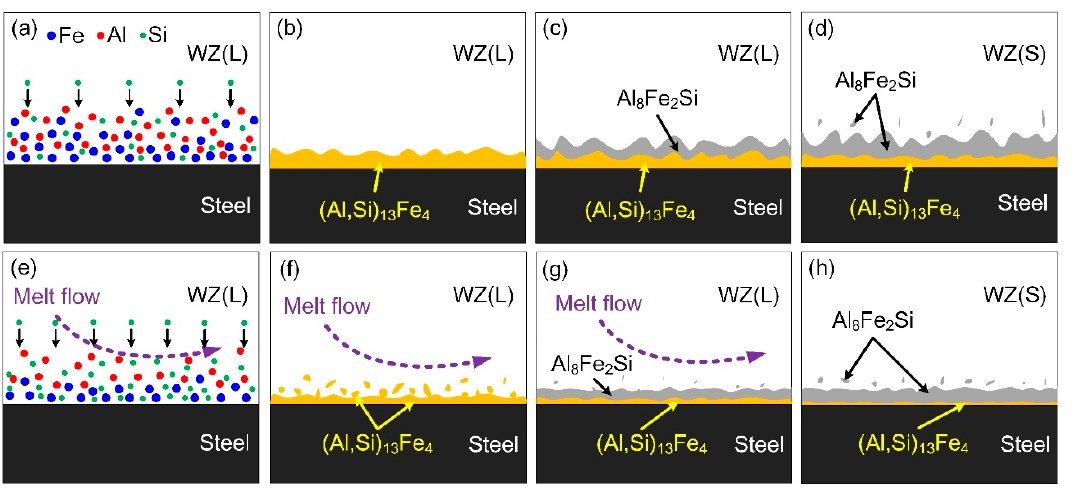
Figure 7. Schematic diagram of IMC layer formation: ( a – d ) In the normal welding process; ( e – h ) with axial magnetic field assisted.